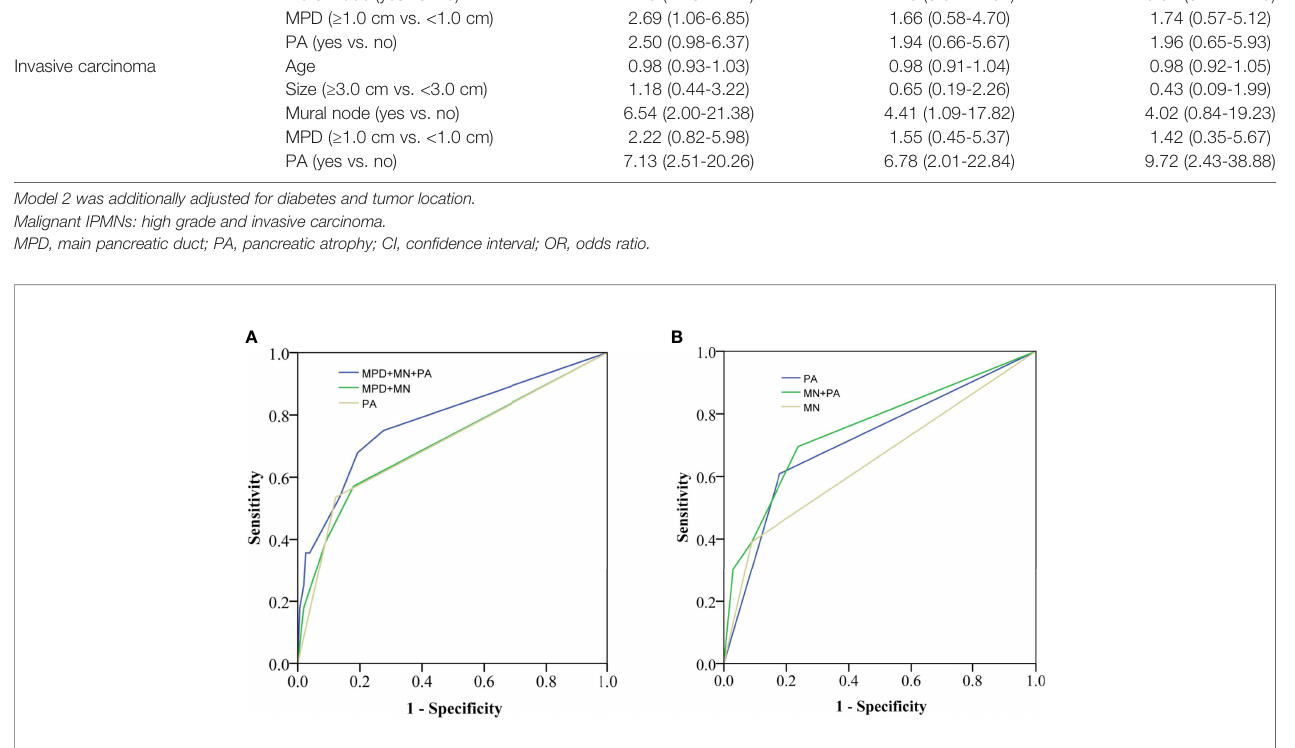
FIGURE 3 | Receiver operating characteristic (ROC) curves for identifying invasive carcinoma in all IPMNs (A) [area under the curve (AUC) = 0.78 vs. 0.71, 0.71] and MD-involved IPMNs (B) (AUC = 0.76 vs. 0.65, 0.71). MPD, main pancreatic duct; MN, mural nodule; PA, pancreatic atrophy.